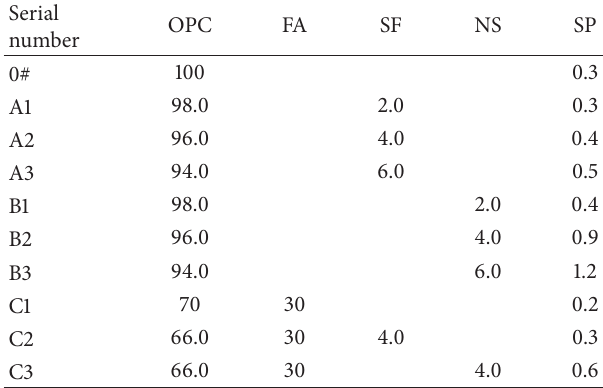
Table 2: Mix proportions of composite cement pastes (unit: